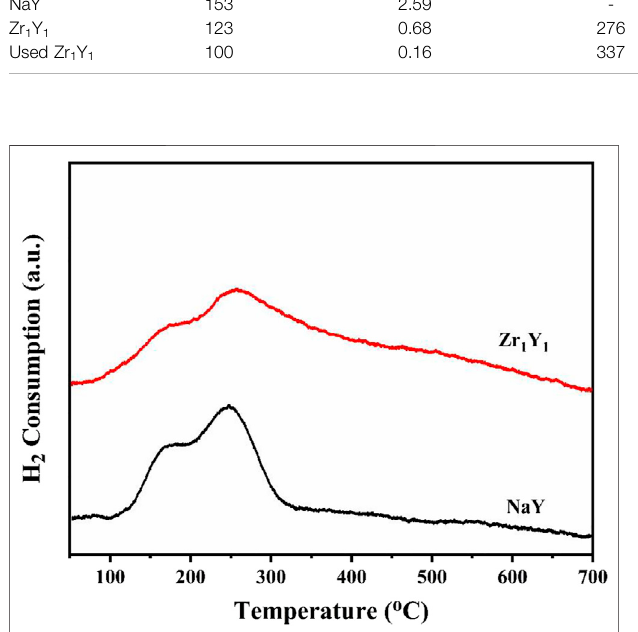
FIGURE 2 | H 2 -TPD pro fi les of the NaY and Zr 1 Y 1 catalysts.